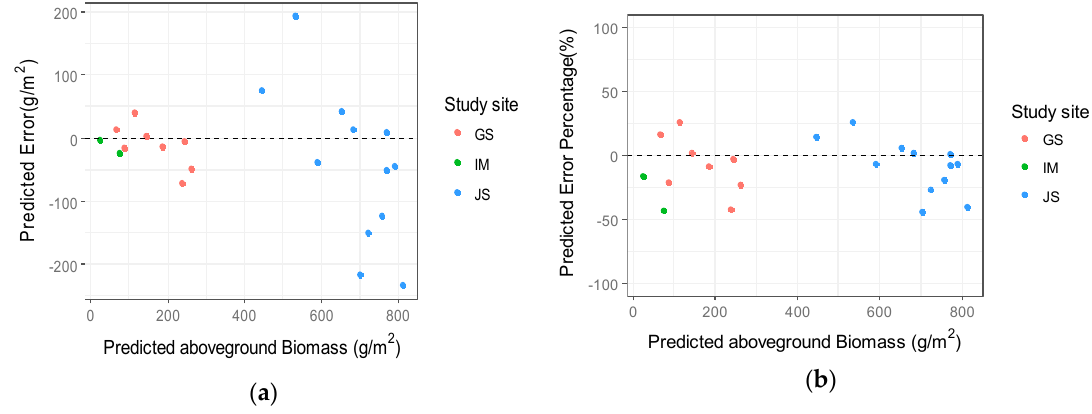
Figure 12. The scatter plots of predicted aboveground biomass and estimation error at quadrat scale ( a ) and the scatter plot of predicted biomass error percentage of different study sites ( b ). GS: Gansu study site; IM: Inner Mongolia study site; JS: Jiangsu study site. Table 5. The errors of predicted aboveground biomass at different sites.